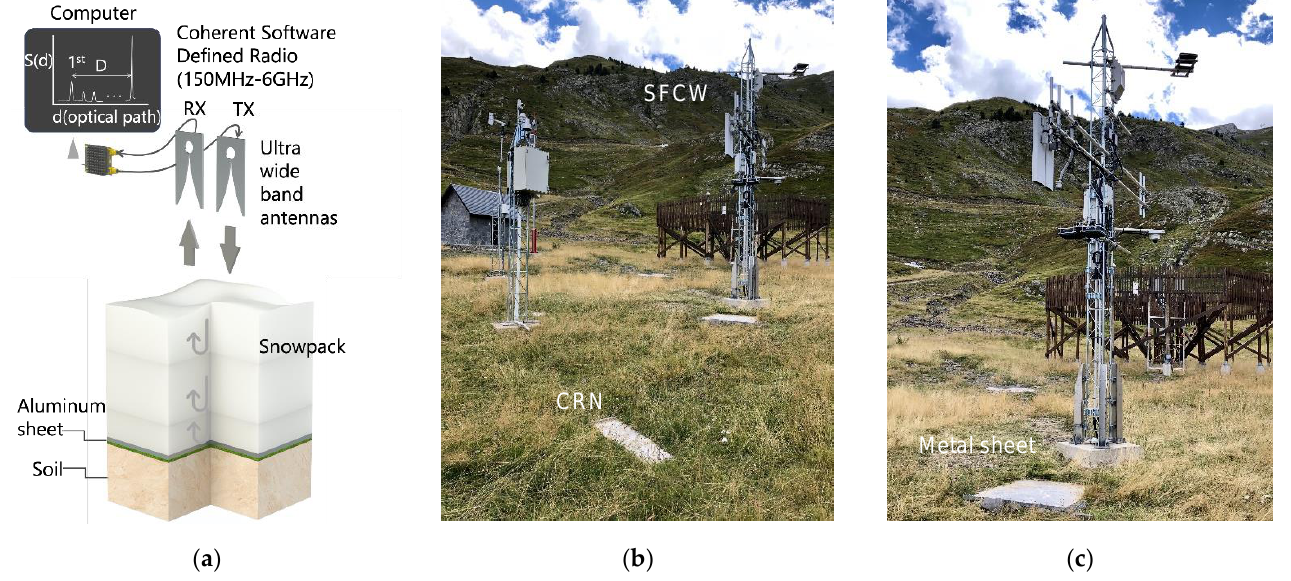
Figure 11. ( a ) Diagram of the SFCW radar measurement process. ( b ) The SAIH-CHE N014 CRN gauge in soil. ( c ) Prototype of the SFCW radar and metal sheet.